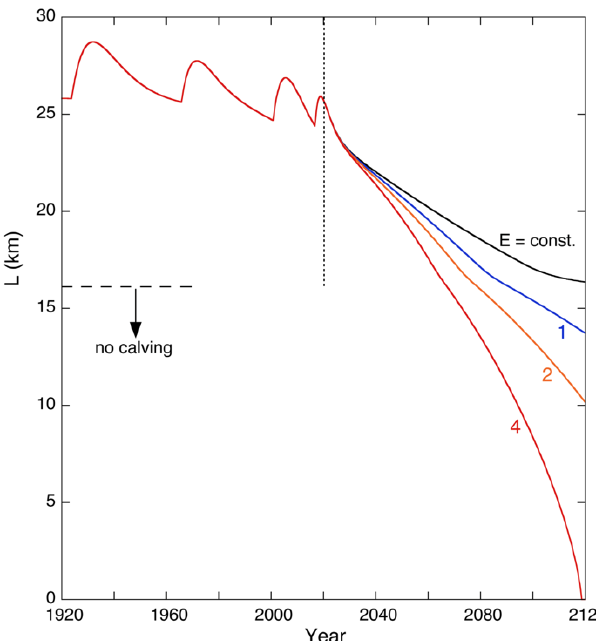
Figure 9. Glacier length L for different climate change experi- ments. The black curve refers to a calculation in which E is kept constant at its 2000–2019 mean value. The colour labels refer to the imposed constant rate of change in E per year from 2020